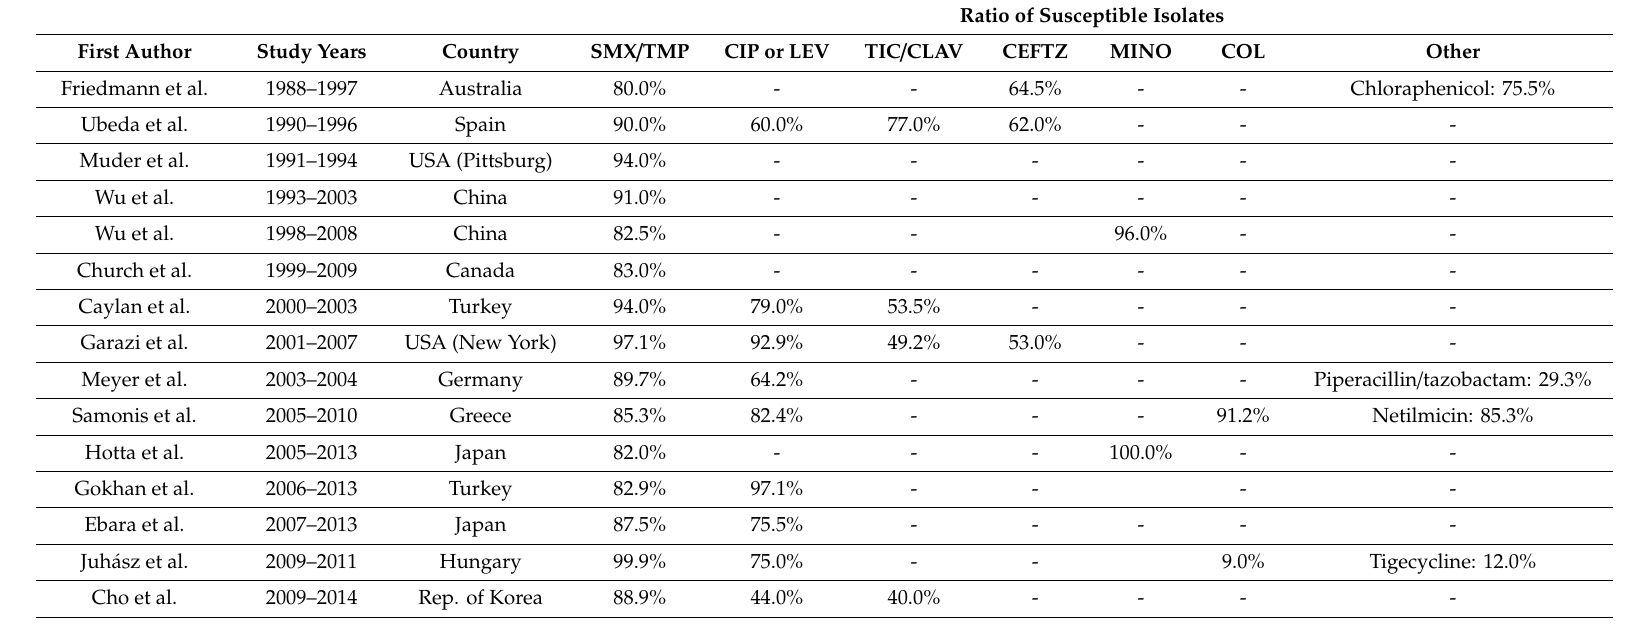
Table 2. Summary of the literature regarding susceptibility trends of S. maltophilia